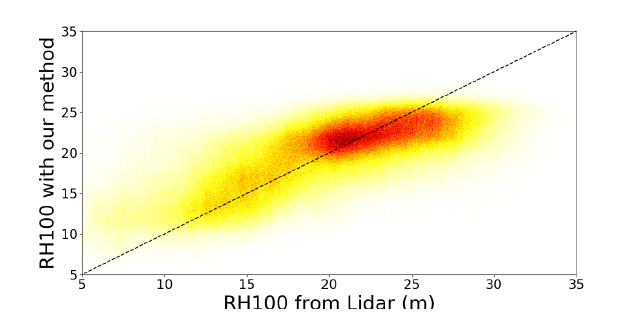
Figure 18. Density plot of LIDAR RH100 VS RH100 estimated by neuronal network.